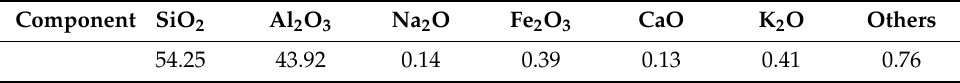
Table 1. Chemical composition of the metakaolin